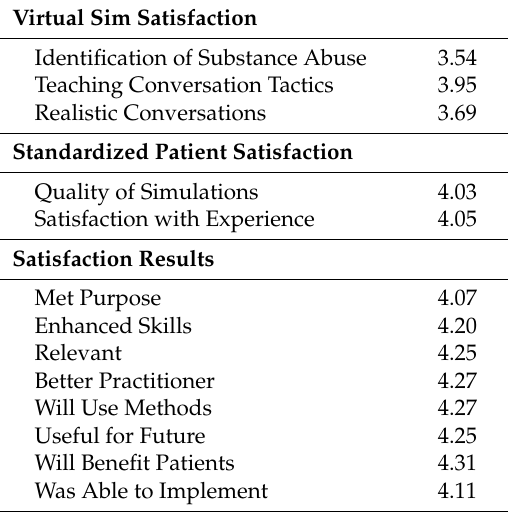
Table 1. Survey/Likert type 1–5 (with 5 being best) administered to students regarding satisfaction with the content and learning activities. N =